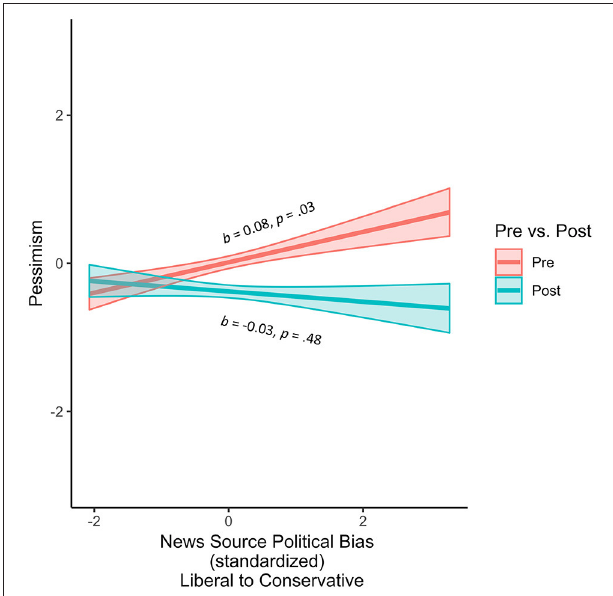
FIGURE 1 | Pessimism as a function of time x news source F (1, 556) = 5.20, p = 0.02, 95% CI[ − 0.10, − 0.01], PRE = 0.01; Scale bands represent 95% confidence